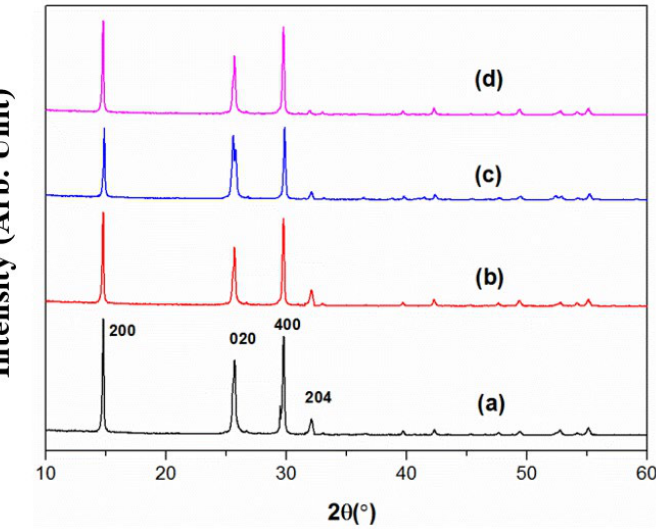
Figure 10. XRD patterns of CSHW with different aspect ratios. (The preparing parameters of ( a – d ) were shown in Table 3).